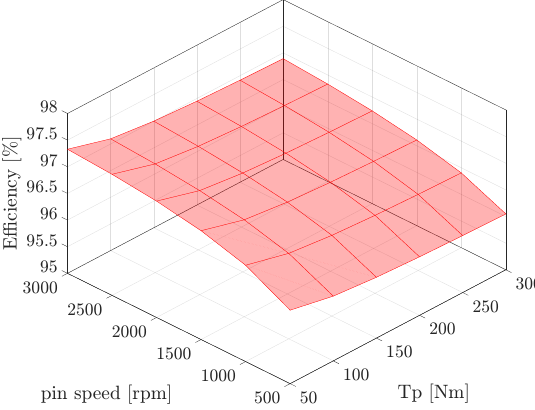
Figure 8. Efficiency map as a function of pinion torque and pinion